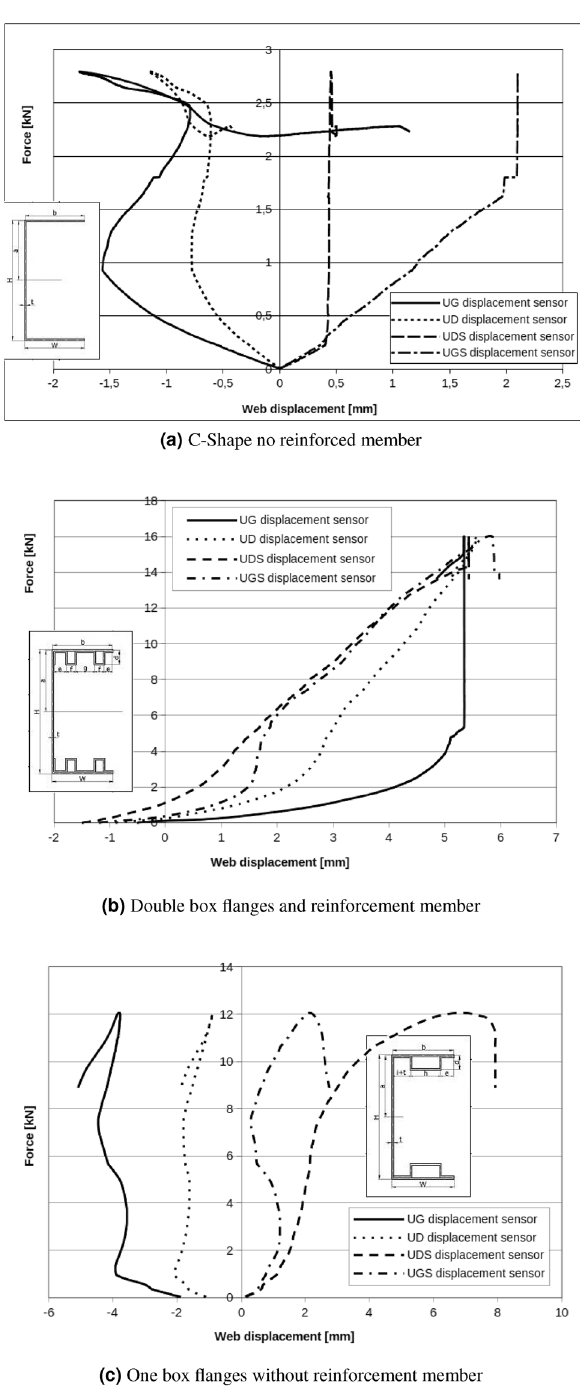
Figure 11. Web displacement points. UG – displacement of the upper web point on the fixed stiff steel plate, UD – displacement of the lower web point on the fixed stiff steel plate, UGS – displacement of the upper web point on the movable stiff steel plate, UDS – displacement of the lower web point on the movable stiff steel